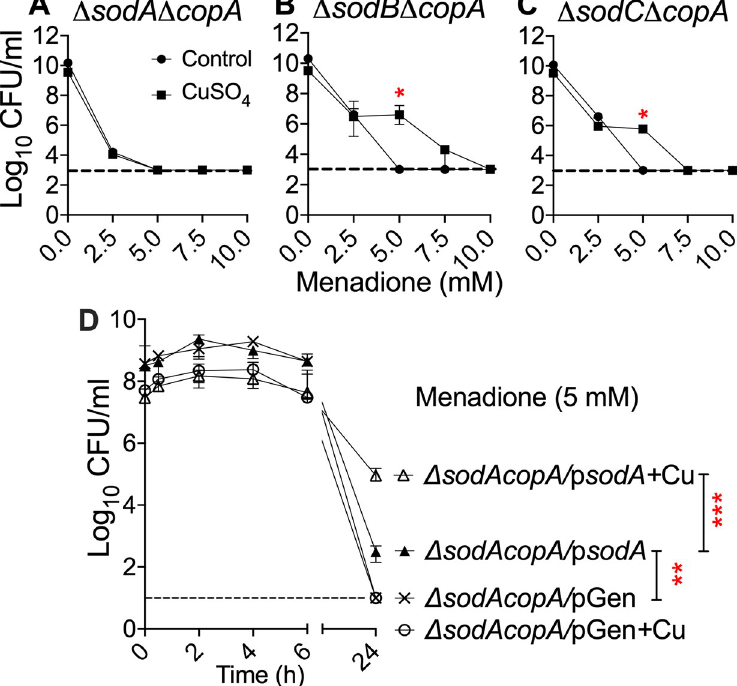
Fig 6. Copper-induced protection from killing by superoxide is dependent on sodA . Double mutants Δ sodA Δ copA (A), Δ sodB Δ copA (B) and Δ sodC Δ copA (C) were grown in LB (circles) and LB with copper (squares) to early logarithmic phase. Menadione was added at indicated concentrations, and viable count was determined after 24 hours. (D) Time course of survival of Δ sodAcopA mutant with empty vector (pGen) or complemented with sodA ( p sodA) . Strains were pre-treated with copper (+Cu) or control prior to addition of menadione (5 mM). Median ± interquartile range of CFU/ml from 3 independent experiments is depicted. Dotted line, limit of detection (1000 or 10 CFU/ml). � P < 0 . 05 , �� P < 0 . 01 ,and ��� P < 0 . 001 , Mann-Whitney test.